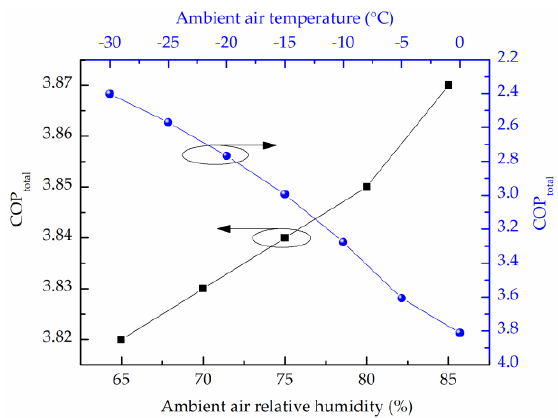
Figure 18. Effects of the ambient air temperature and its relative humidity on the total coefficient of performance (COP total ) of FFASHP system [73].